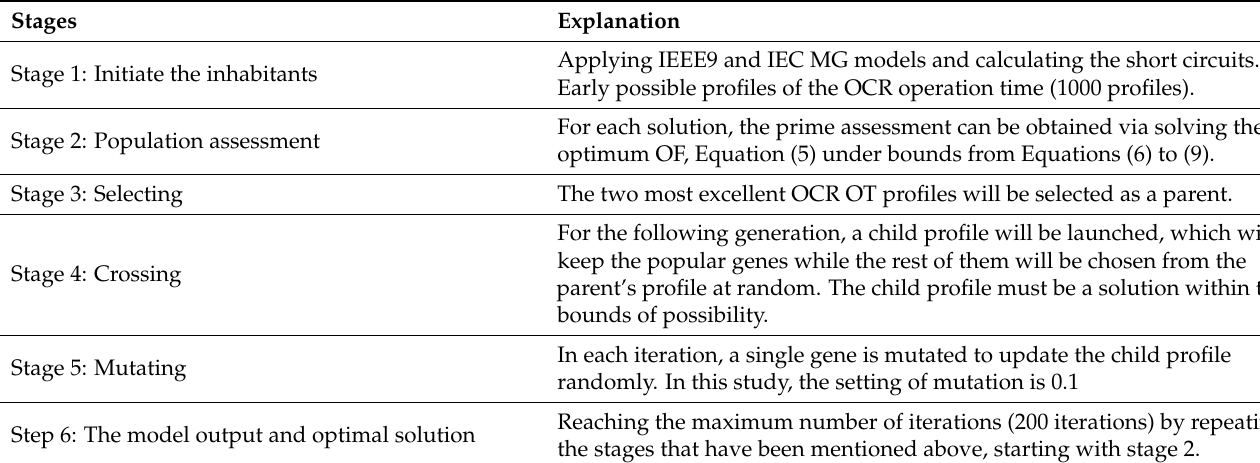
Table 2. The procedures of the GA